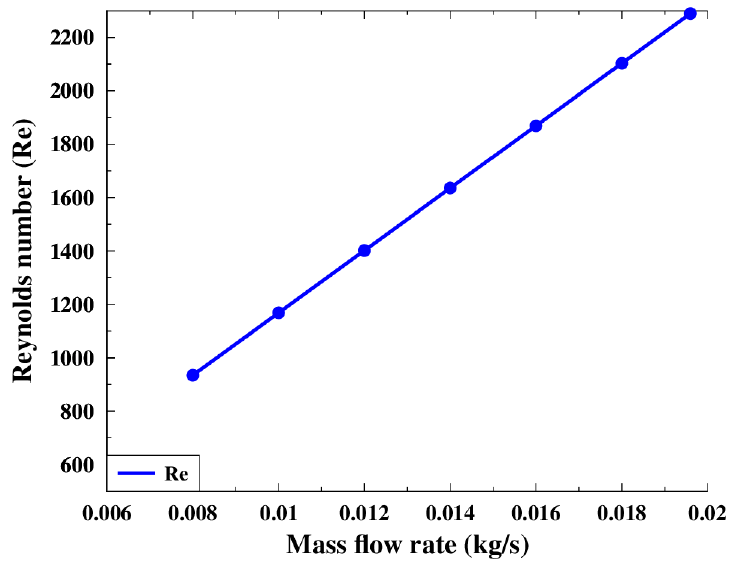
Figure 10. Variation in Reynolds number with pressure difference (Pa).